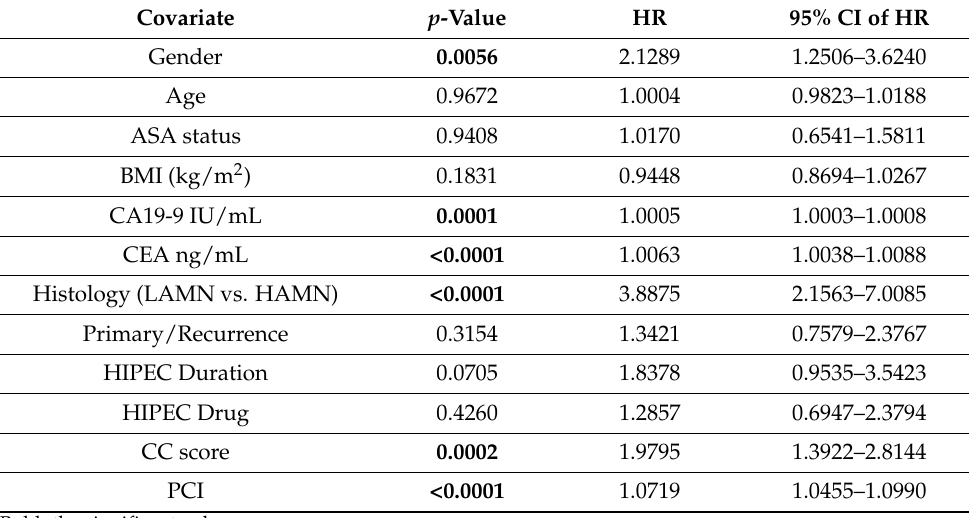
Table 3. Univariate Cox regression for PFS. HR: hazard rate, CI: confidence interval.